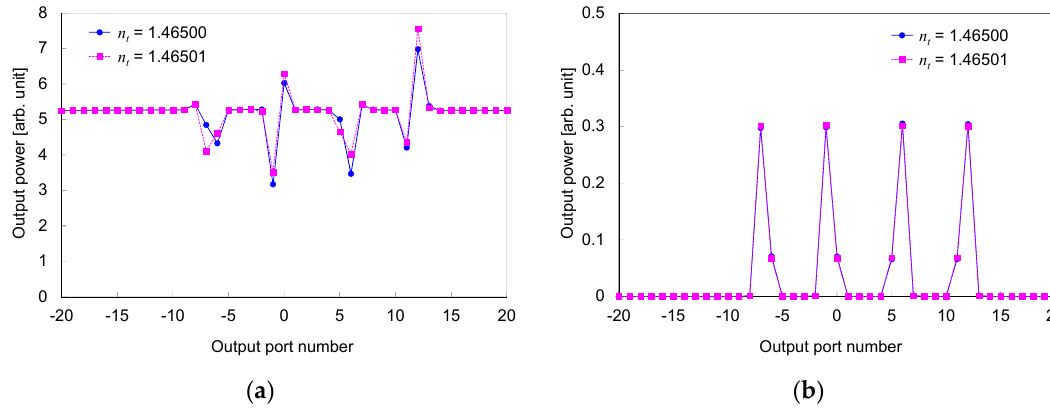
Figure 5. Output power from output ports for two values of n t differed by 1 × 10 –5 . ( a ) Proposed structure. ( b ) Structure without broad beam.